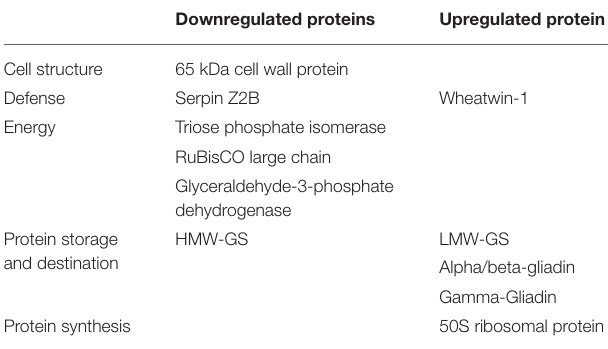
TABLE 3 | List of differentially expressed proteins under both day and day–night heat